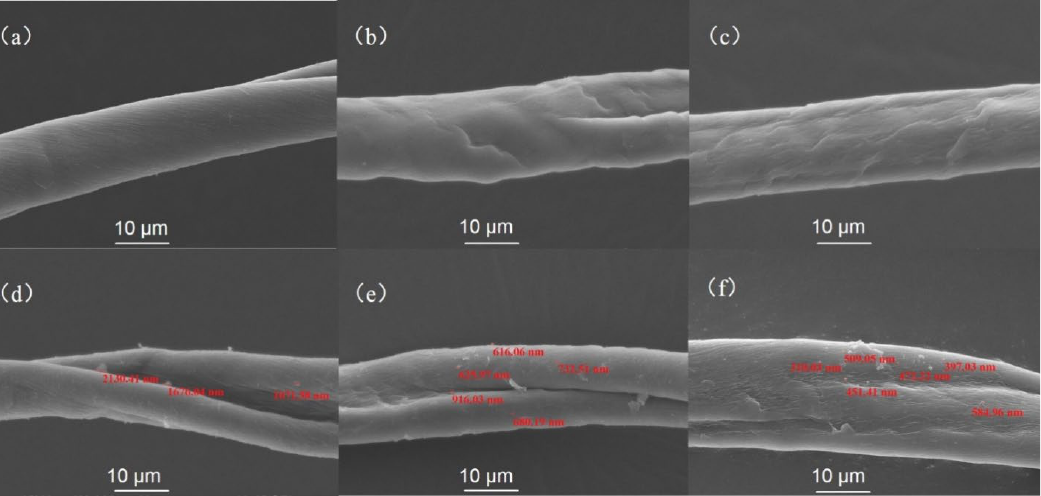
Figure 9. SEM images of samples after UV aging: ( a ) CF; ( b ) CF-UV-48 h; ( c ) CF-UV-196 h; ( d ) CF-TiO 2 ; ( e ) CF-TiO 2 -UV-48 h; ( f ) CF-TiO 2 -UV-196 h.